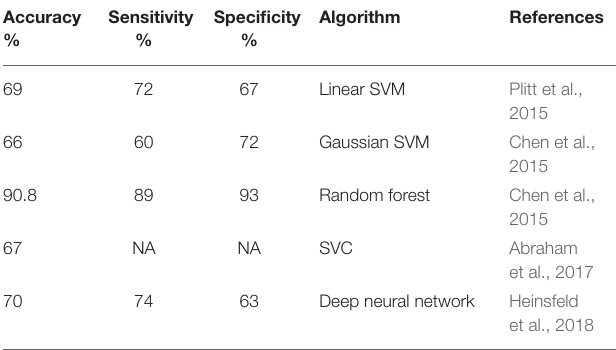
TABLE 3 | Previous model performance on the ABIDE